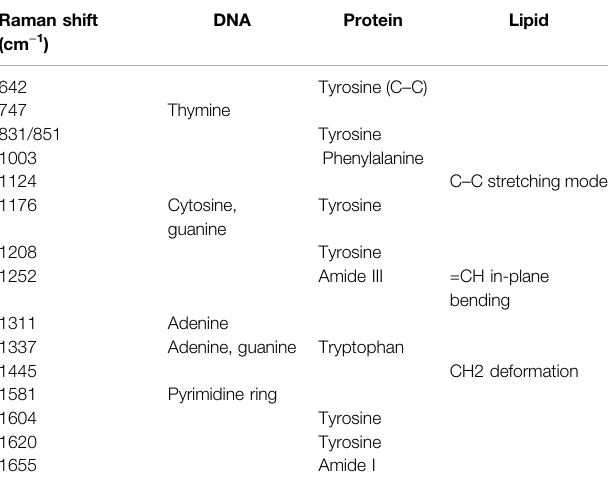
TABLE 2 | The representative peak assignments in cell Raman spectra (Stone et al., 2004; Notingher and Hench, 2006; Wood et al., 2007; Surmacki et al., 2015).